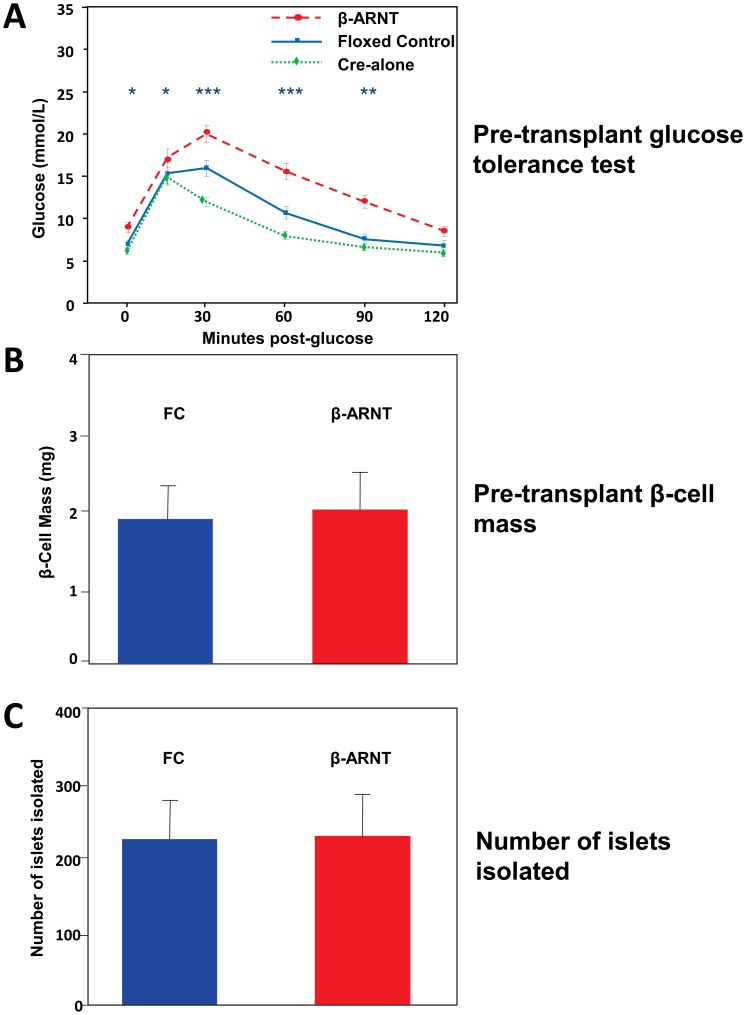
Pre-transplant glucose tolerance and β-cell mass and number of islets isolated.(A) β-ARNT donor mice had significant glucose intolerance compared to floxed controls and RIP-CRE alone mice (*** = p<0.001, ** = p<0.01, * = p<0.05). (B) Both β-ARNT and control mice show similar β-cell mass pre-transplantation. (C) Both β-ARNT and control mice had similar number of islets isolated. Average = 236 islets/β-ARNT mouse and 231 islets/control mouse. Data are presented as means ± SEMs.